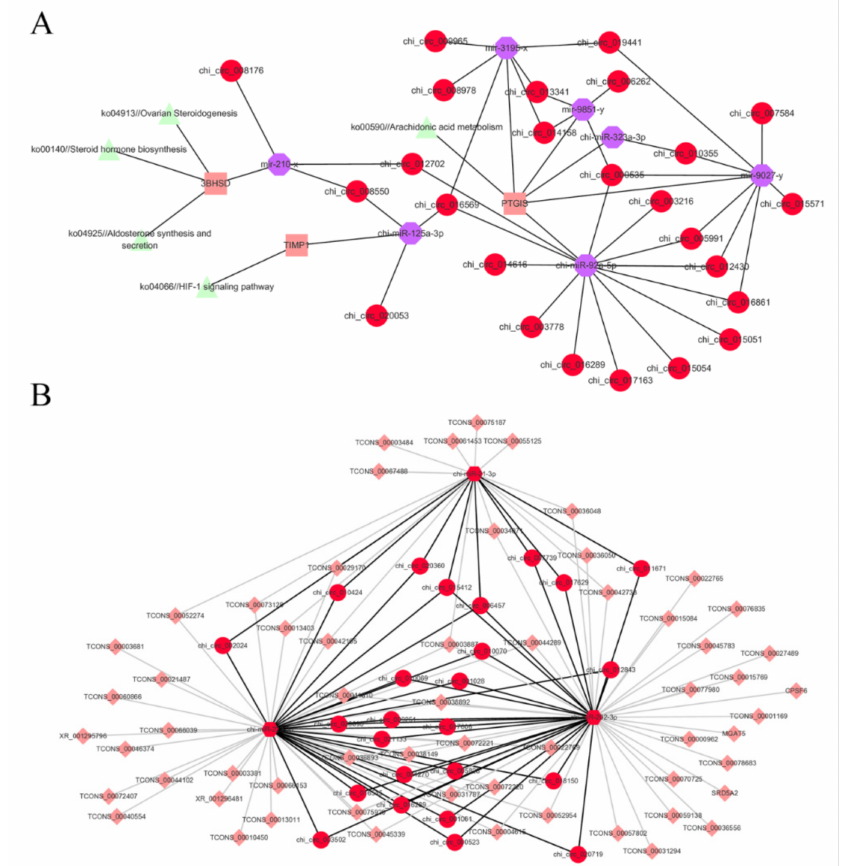
Figure 5. Predicted competing endogenous RNA (ceRNA) networks. ( A ) Predicted interaction between TIMP1 , 3BHSD, or PTGIS and differentially expressed miRNAs as well as circRNAs. The differentially expressed miRNAs that were predicted to target TIMP1 , 3BHSD, or PTGIS and dif- ferentially expressed circRNAs that could be miRNA sponges were screened to build a circRNA- miRNA-mRNA network.TTIMP1, 3BHSD and PTGIS were involved in the network. ( B ) Predicted target mRNAs/lncRNAs and circRNA sponges of miR-21-3p, miR-202-3p, and miR-223-3p. The circRNAs that could potentially sponge more than two of miR-21-3p, miR-202-3p, and miR-223-3p were screened to display. The predicted target mRNAs/lncRNAs were screened, and the most prominent 25 mRNAs/lncRNAs were shown in the